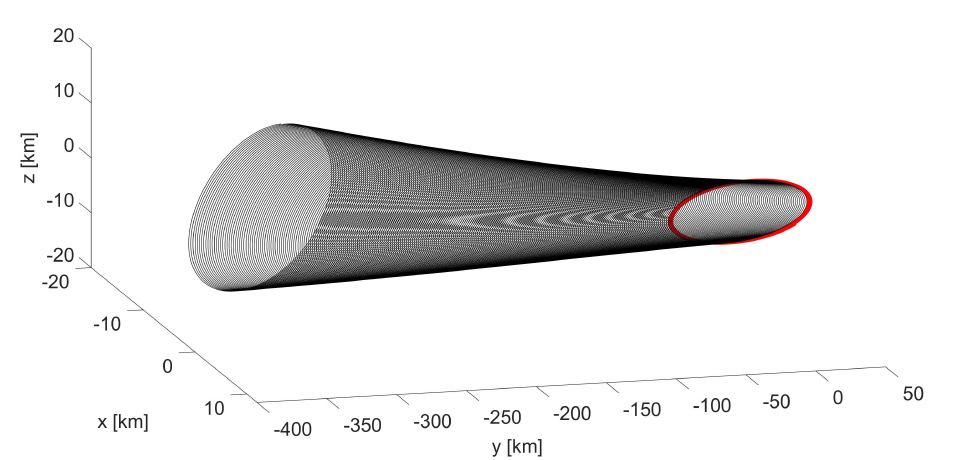
Figure 6. Mid-inclination LEO formation: trajectory (black) in F r resulting from non-invariant initial conditions; the first orbit is plotted in